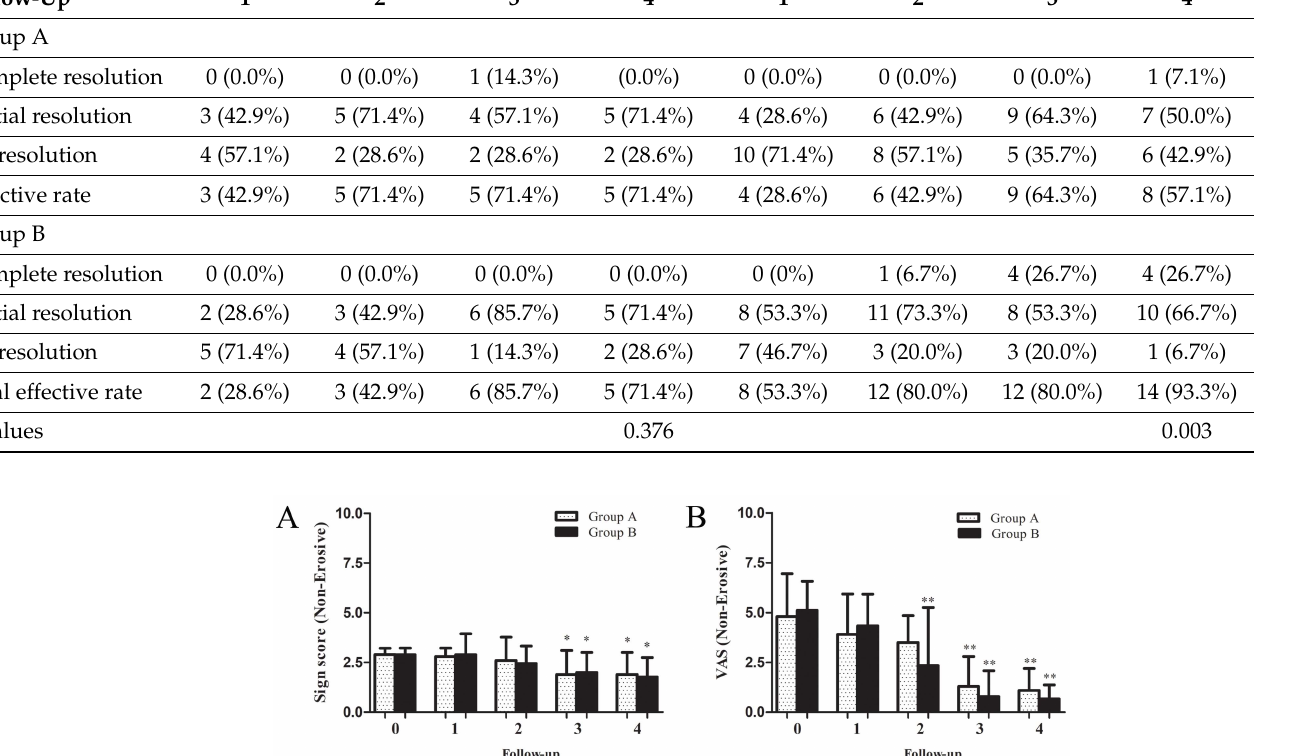
Table 5. Comparison of the treatment effective rate between groups with different sites of mucosal involvement.